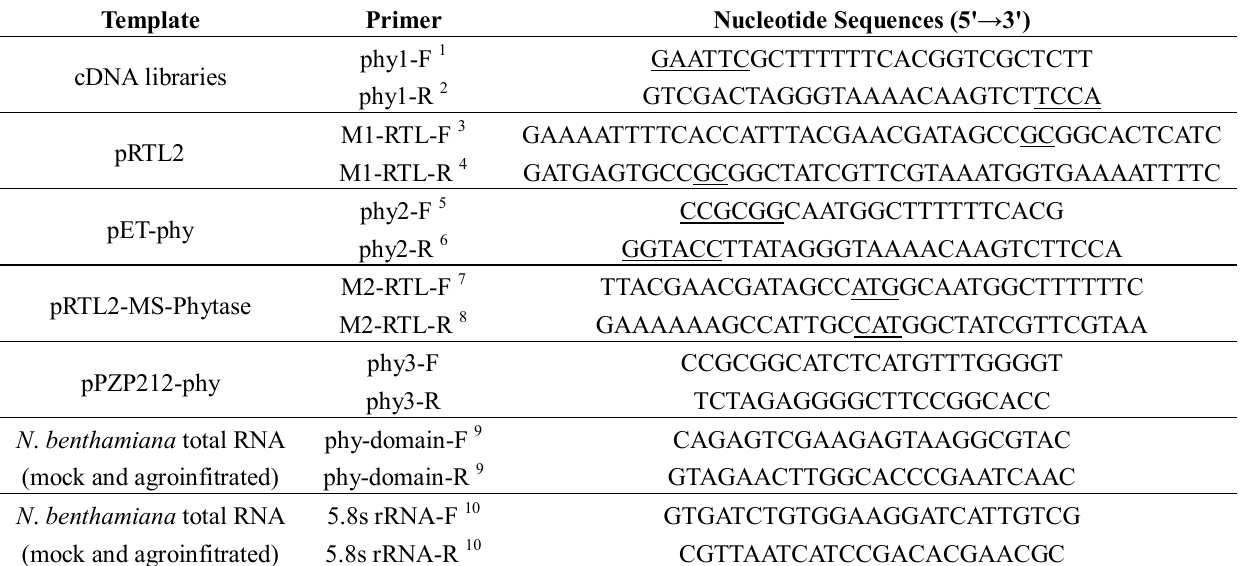
Table 1. Primers used in this